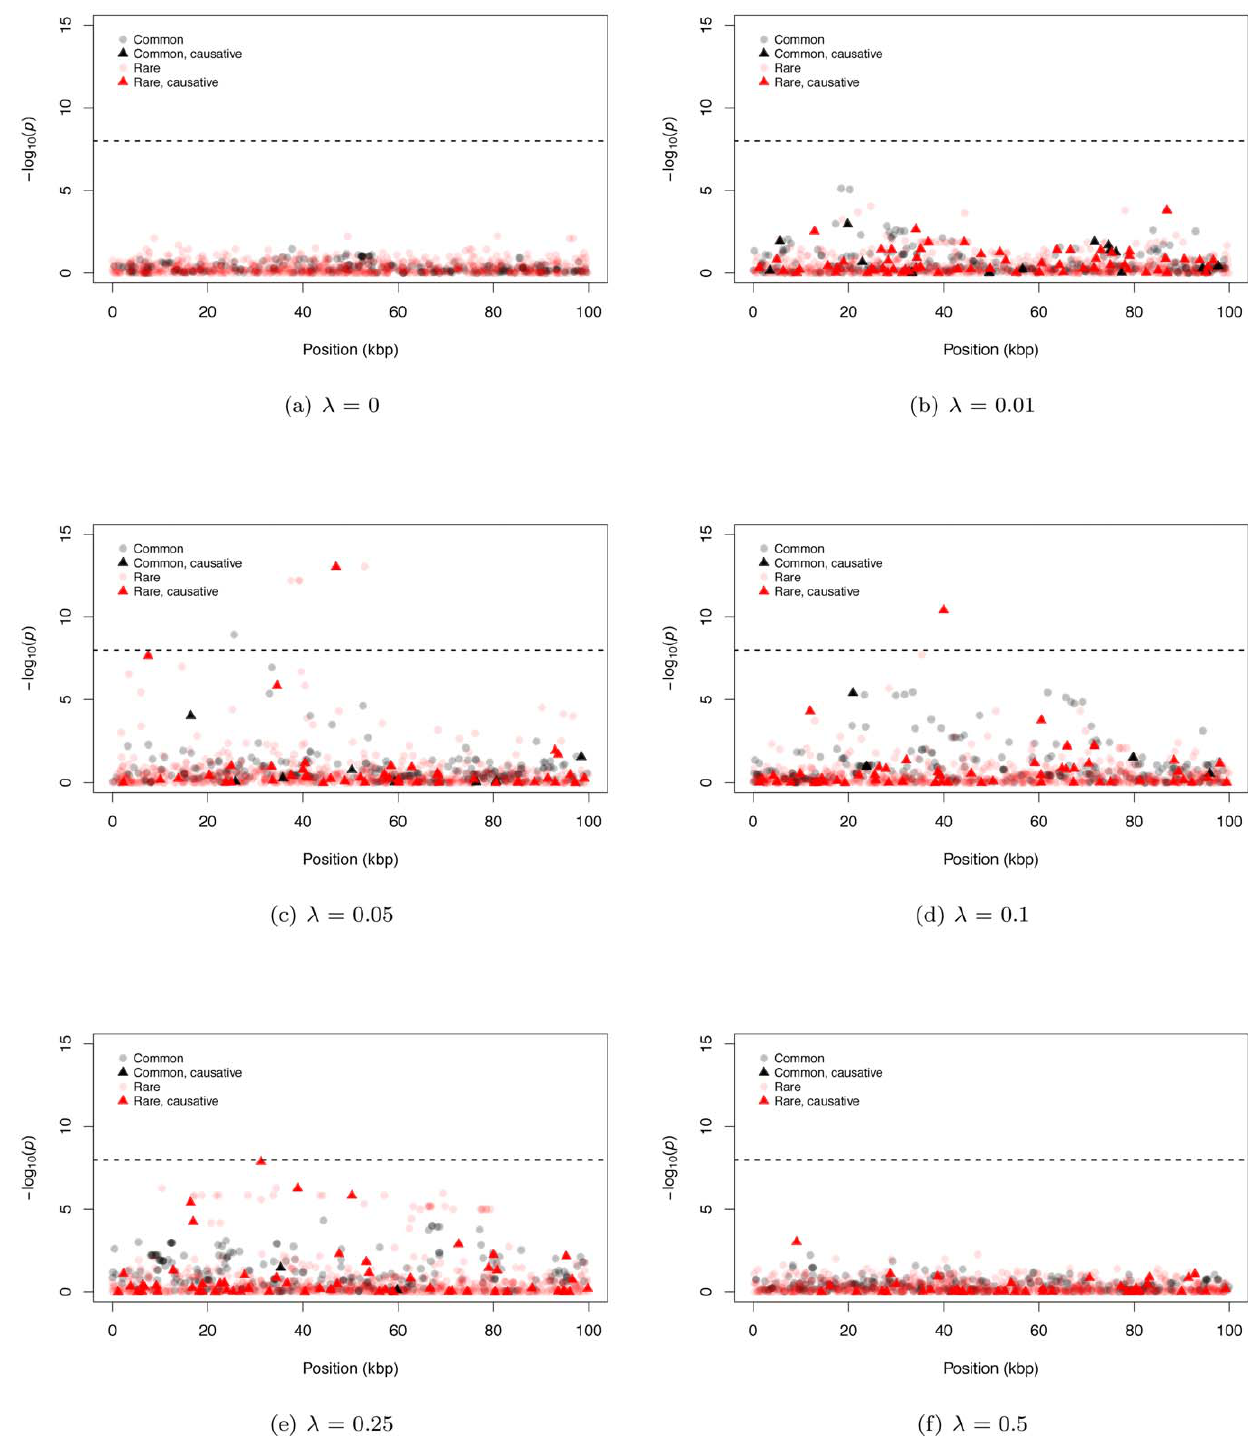
Figure 2. Representative Manhattan plots. The dashed horizontal line corresponds to a p-value of 10 2 8 . (a–f) The 2 log 10 of the p-value of the logistic regression is shown for representative examples for different mean effect sizes of causative mutations ( l ). The plots are separated into four classes of mutations: common neutral and causative variants, which could be typed in a GWAS, and rare neutral and causative variants which would only be directly typed by resequencing. doi:10.1371/journal.pgen.1003258.g002 profiles. For resequencing studies, power maximizes at 54.5% (Figure 3d; Madsen Browning weights are not equivalent to the when l = 0.05, with the power being greatest when using Madsen test proposed in [16]). When applied to non-recombining regions, and Browning’s [16] weighting scheme for individual markers we observe approximately 10% less power across all effect sizes,